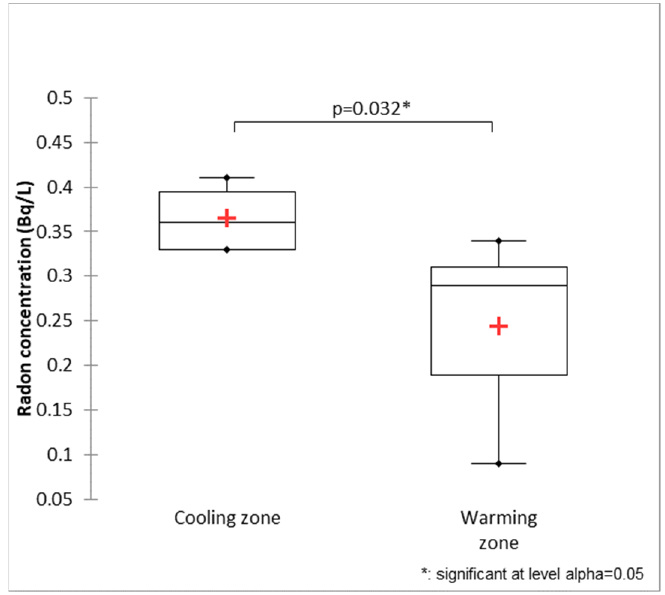
Figure 7. Cooling zones and radon sampling points of Saint-Marguerite River.